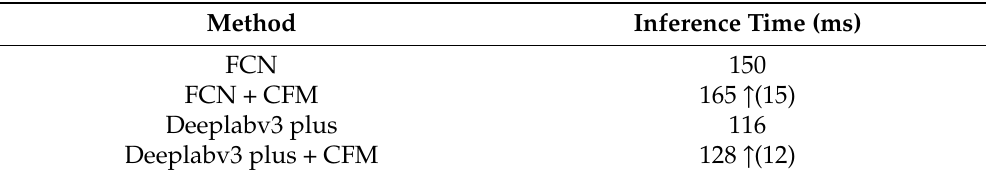
Table 9. Inference time of our